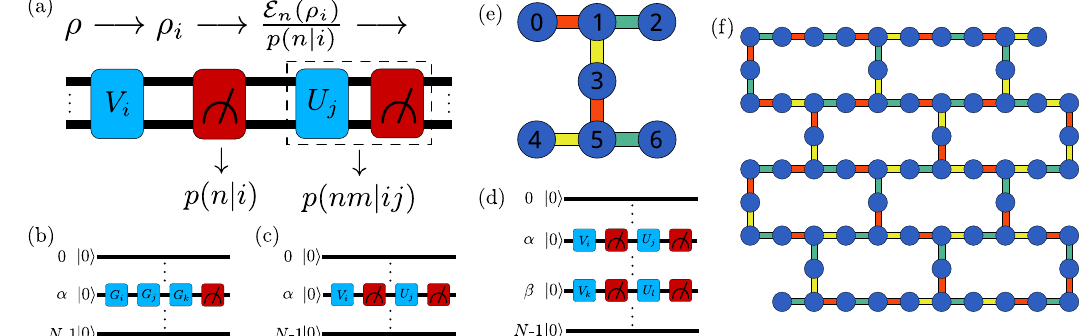
Fig. 1 Quantum circuits and parallelization strategies in the QND measurement tomography. Quantum circuits for a QND measurement tomography of generic measurements, b single-qubit gate set tomography, and c single-qubit and d two-qubit QND measurement tomography. e , f Schemes of IBM quantum devices ( e ) ibm_perth (7 qubits) and ( f ) ibm_brooklyn (65 qubits). Measurements of pairs of qubits connected by a bar of the same color (red, green and yellow) are characterized simultaneously in one run of the parallel